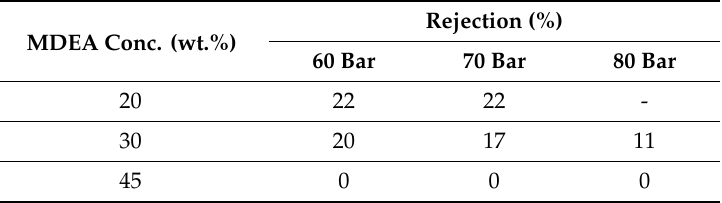
Table 2. The rejection of MDEA from MDEA solutions at di ff erent pressures. Rejection (%) MDEA Conc. (wt.%) 60